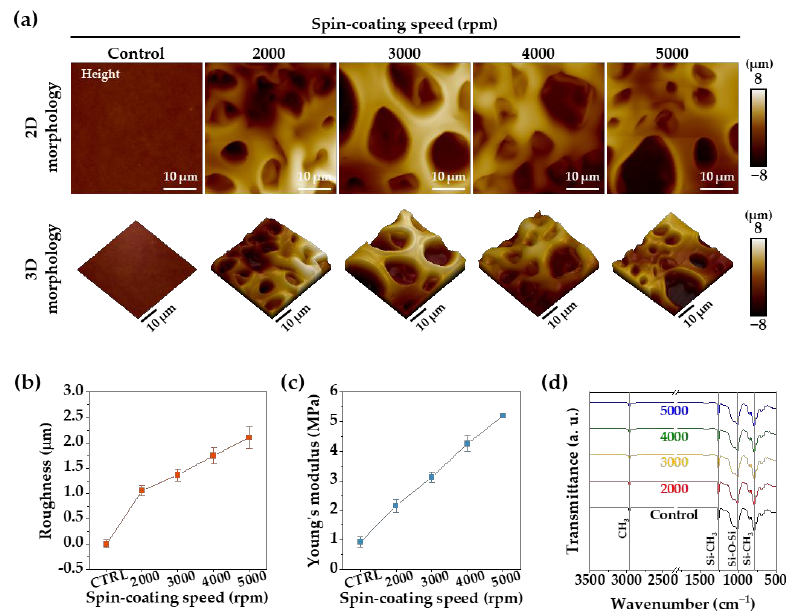
Figure 3. ( a ) The 2D and reconstructed 3D AFM images of the PDMS membranes. ( b ) Surface roughness of PDMS membranes obtained from the AFM analyses. ( c ) Young’s modulus of the PDMS membranes obtained from the AFM analyses. ( d ) ATR-FTIR spectra of the PDMS membrane surface. Cell growth on the PDMS membranes was evaluated through the cell viability using